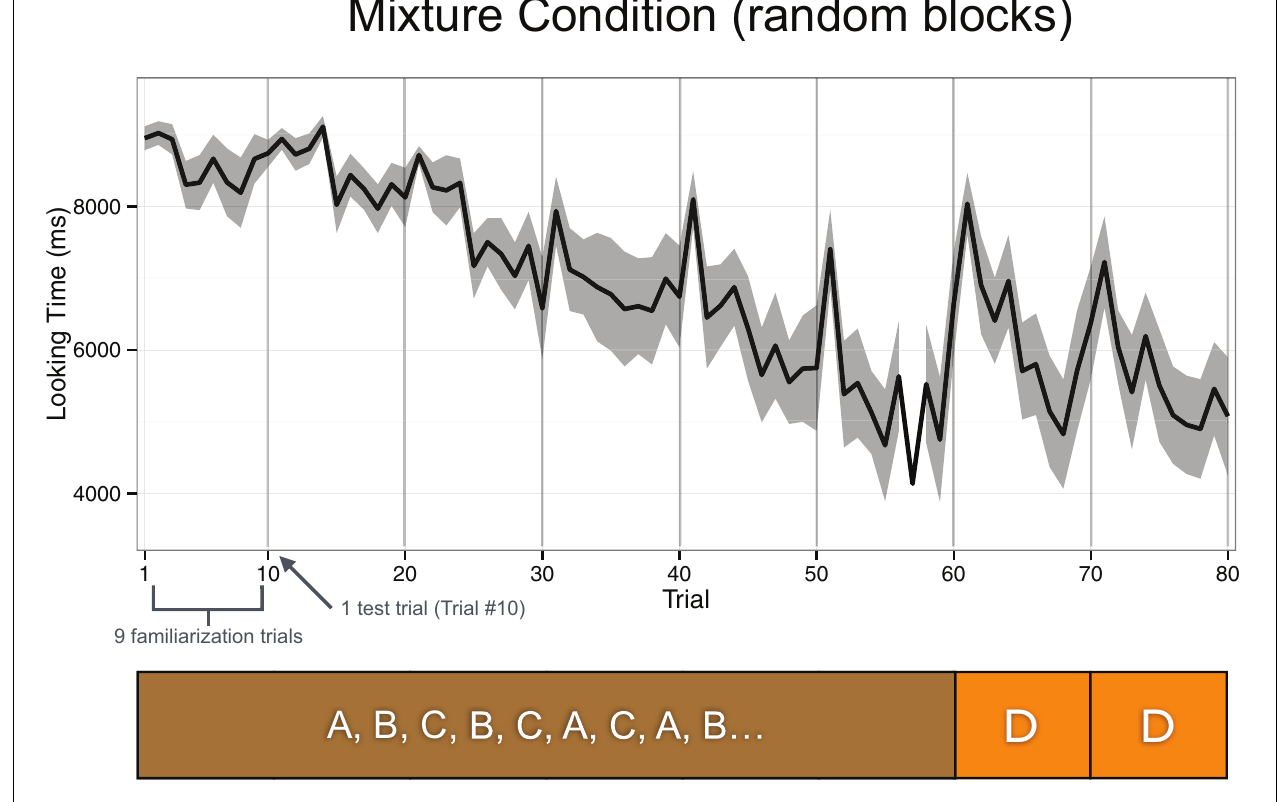
FIGURE 3 | Raw looking times across trials throughout the Mixture condition. The test trials are depicted by the vertical lines (trials 10, 20, 30, etc.), and the familiarization trials were trials 1–9 in every half block.